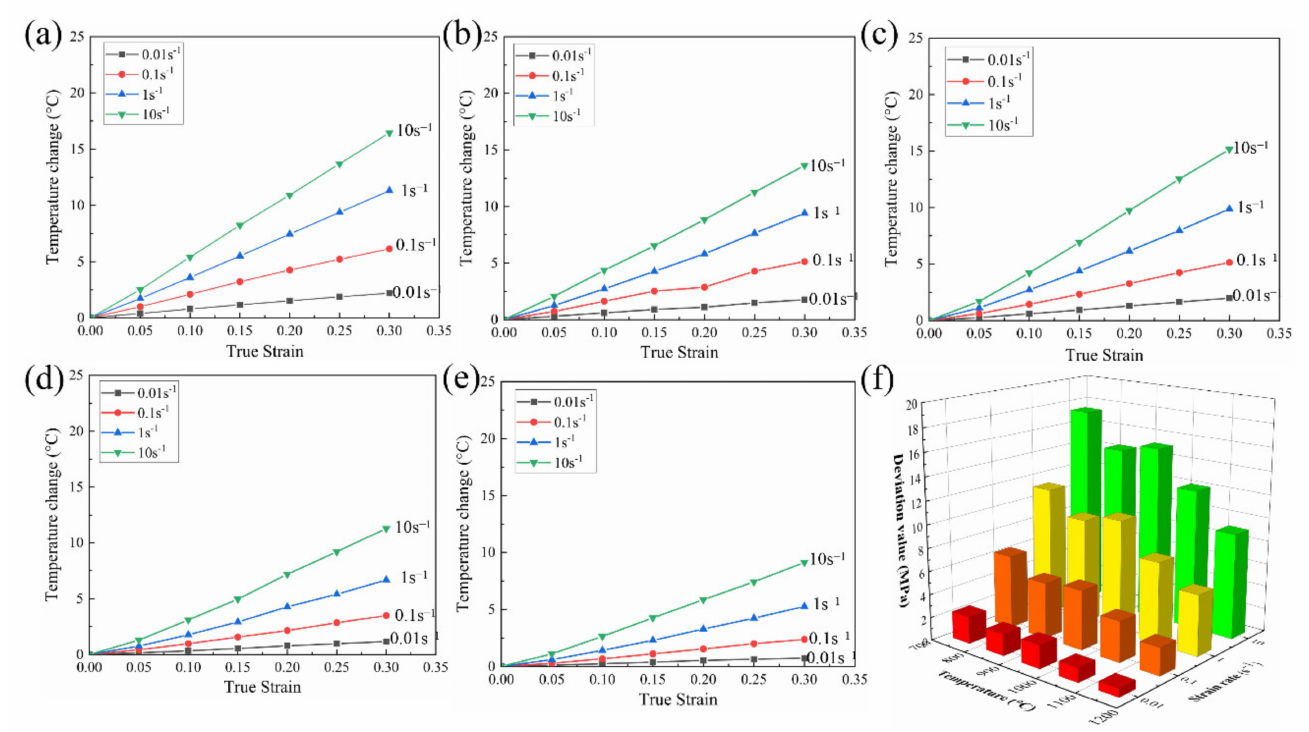
Figure 5. Temperature variation of F92 steel (0.3) at different temperatures: ( a ) 750 ◦ C, ( b ) 850 ◦ C, ( c ) 950 ◦ C, ( d ) 1050 ◦ C, ( e ) 1150 ◦ C; ( f ) temperature deviation